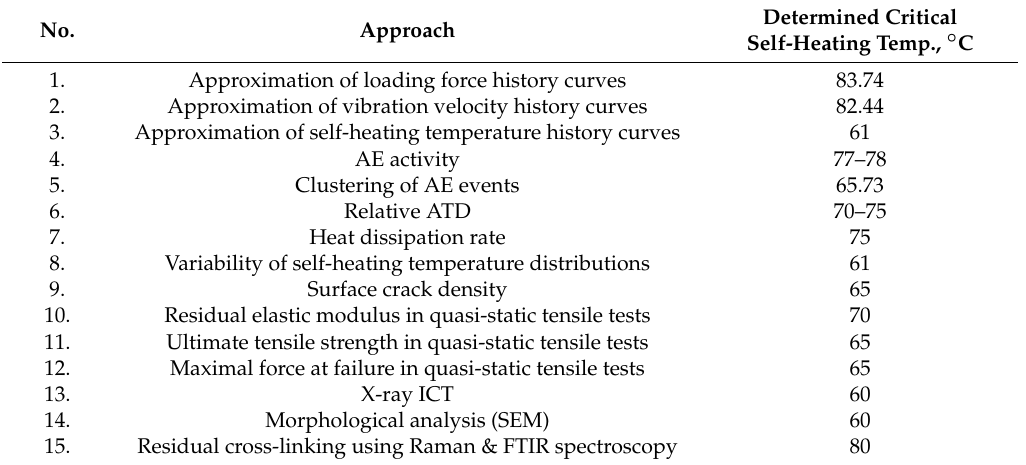
Comparison of the critical self-heating temperature values determined using various